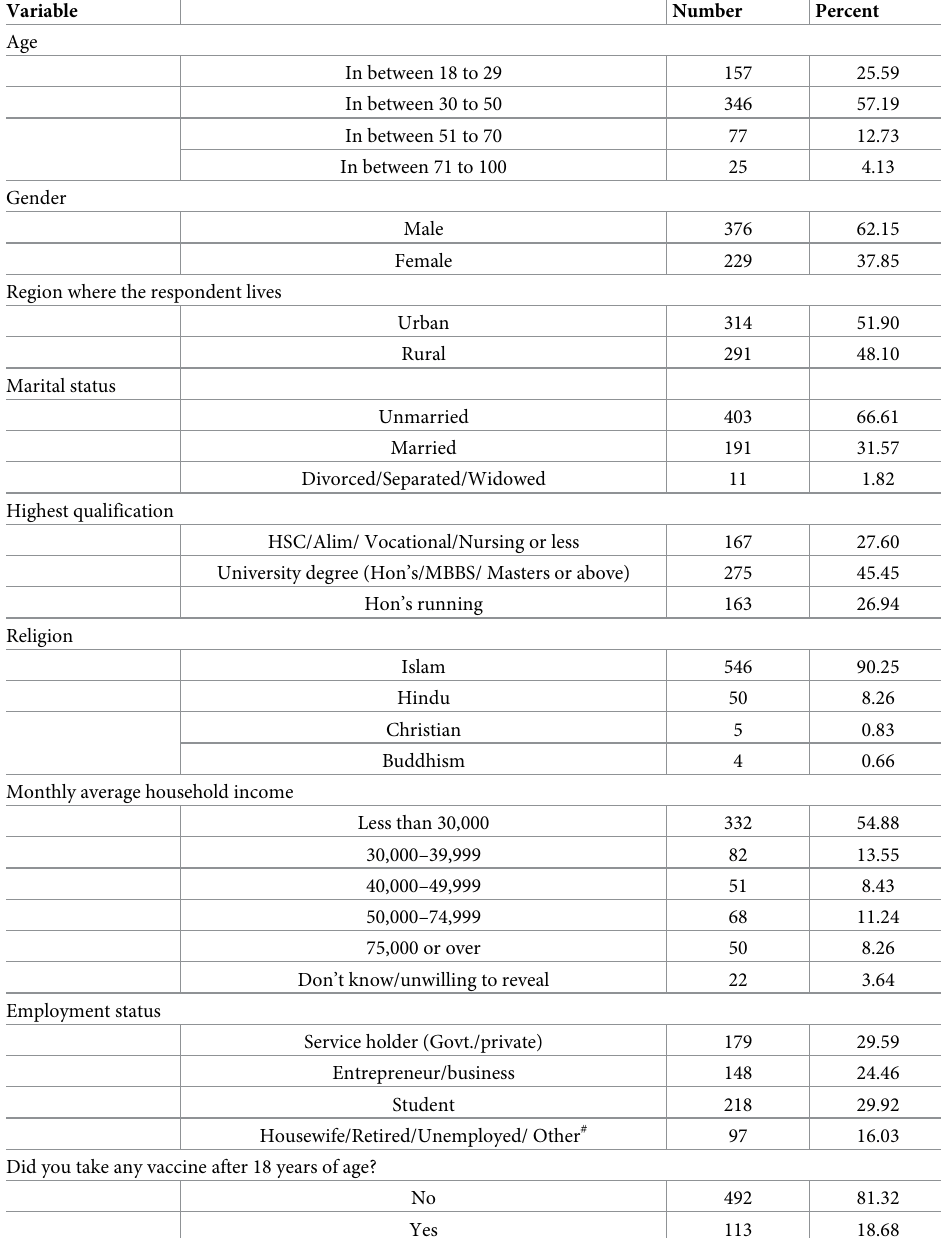
Table 1. Participant characteristics (n =